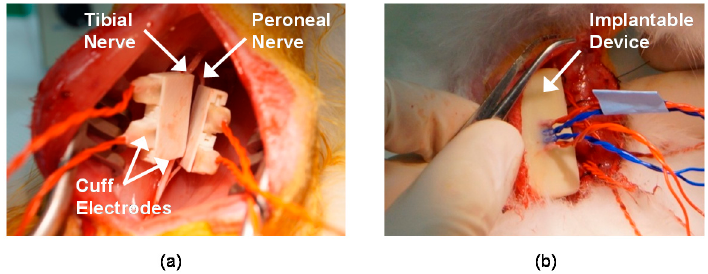
Figure 9. Surgical procedure for implant placement: ( a ) cuff electrodes wrapped around the tibial and peroneal nerves, ( b ) implantable device inserted under the back skin of a rabbit.